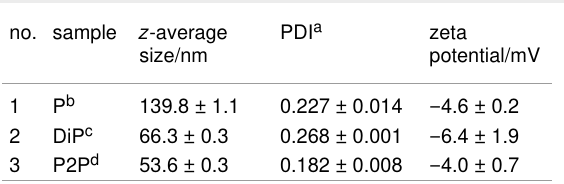
with the same process. Particle size and zeta potential of the phytosomes were measured by dynamic light scattering (DLS).